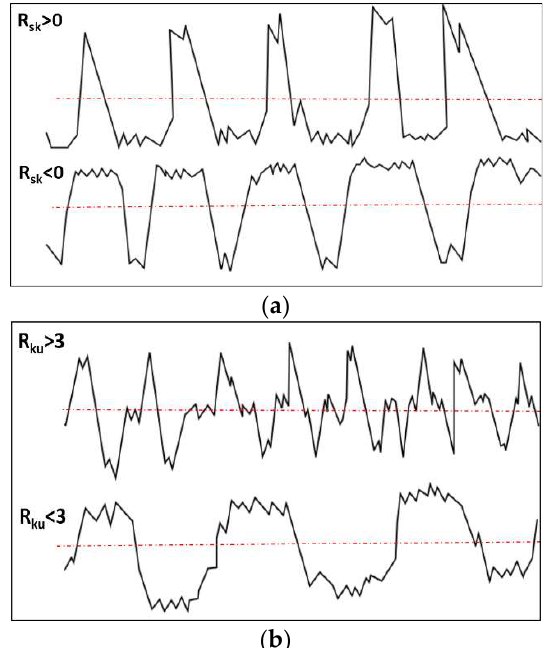
Figure 3. Representation of the Skewness parameter ( a ) and Kurtosis parameter ( b ).